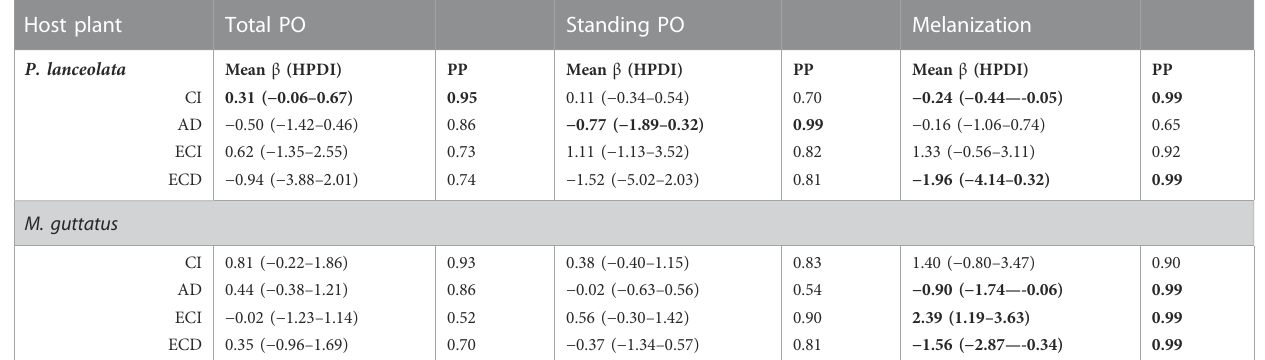
TABLE1Statisticalresults ofthe regression analysistestingtheeffects offeeding ef fi ciencymeasurementsonthe threeimmuneresponseassays.The meaneffect size and 95% highest posterior density interval (HPDI) for the three immune response parameters, total PO, standing PO, and melanization are shown. The Bayesian posterior probability (PP) represents the pairwise comparisons of each feeding ef fi ciency measurement and immune response assay. Negative mean values indicate a negative relationship between the feeding ef fi ciency parameter and the measured immune response, and likewise for positive mean values. Bolded numbers are PPs higher than